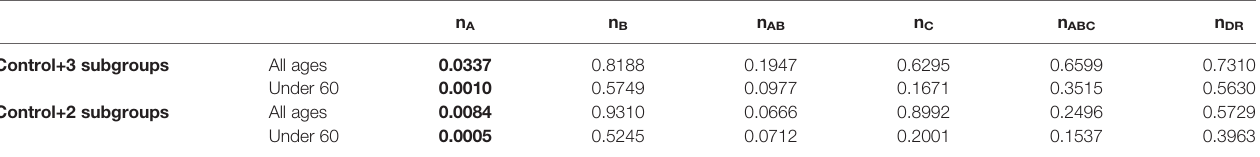
TABLE 3 | p-values ( p < 0.05 in bold) from generalized linear models (GLM) between severity (control + 3 patient subgroups or control + 2 subgroups) and numbers of SARS-CoV-2-derived peptides predicted as weak binders of HLA molecules (HLA-A: n A ; HLA-B: n B ; HLA-A and -B: n AB ; HLA -C: n C ; HLA-A, -B and -C: n ABC ; HLA-DR: n DR ) according to %Rank for individuals of all ages or those under 60 years